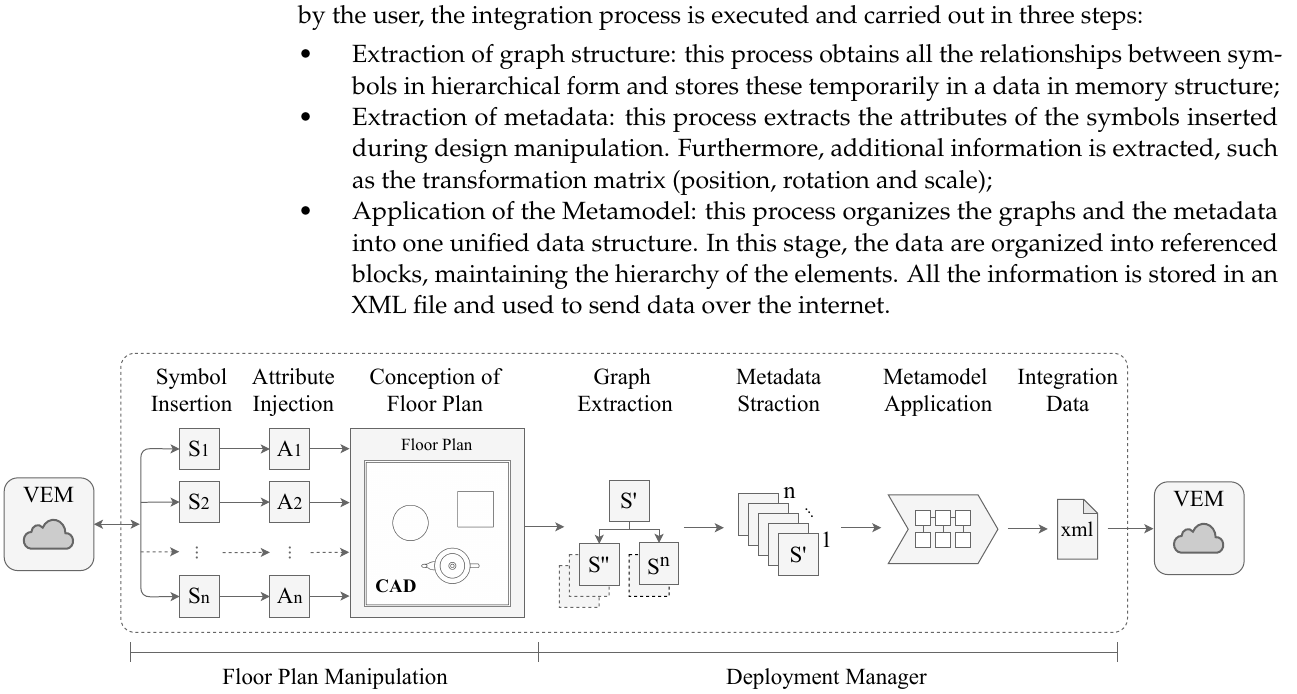
Figure 5. Conceptual diagram of the floor plans integration process between CAD Editor and Virtual Reality